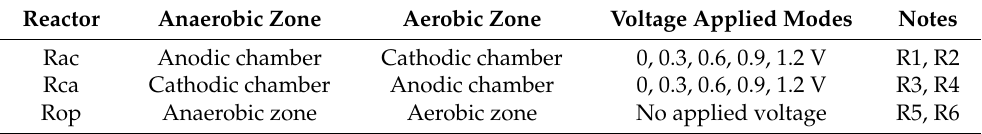
Table 1. Operational conditions of the